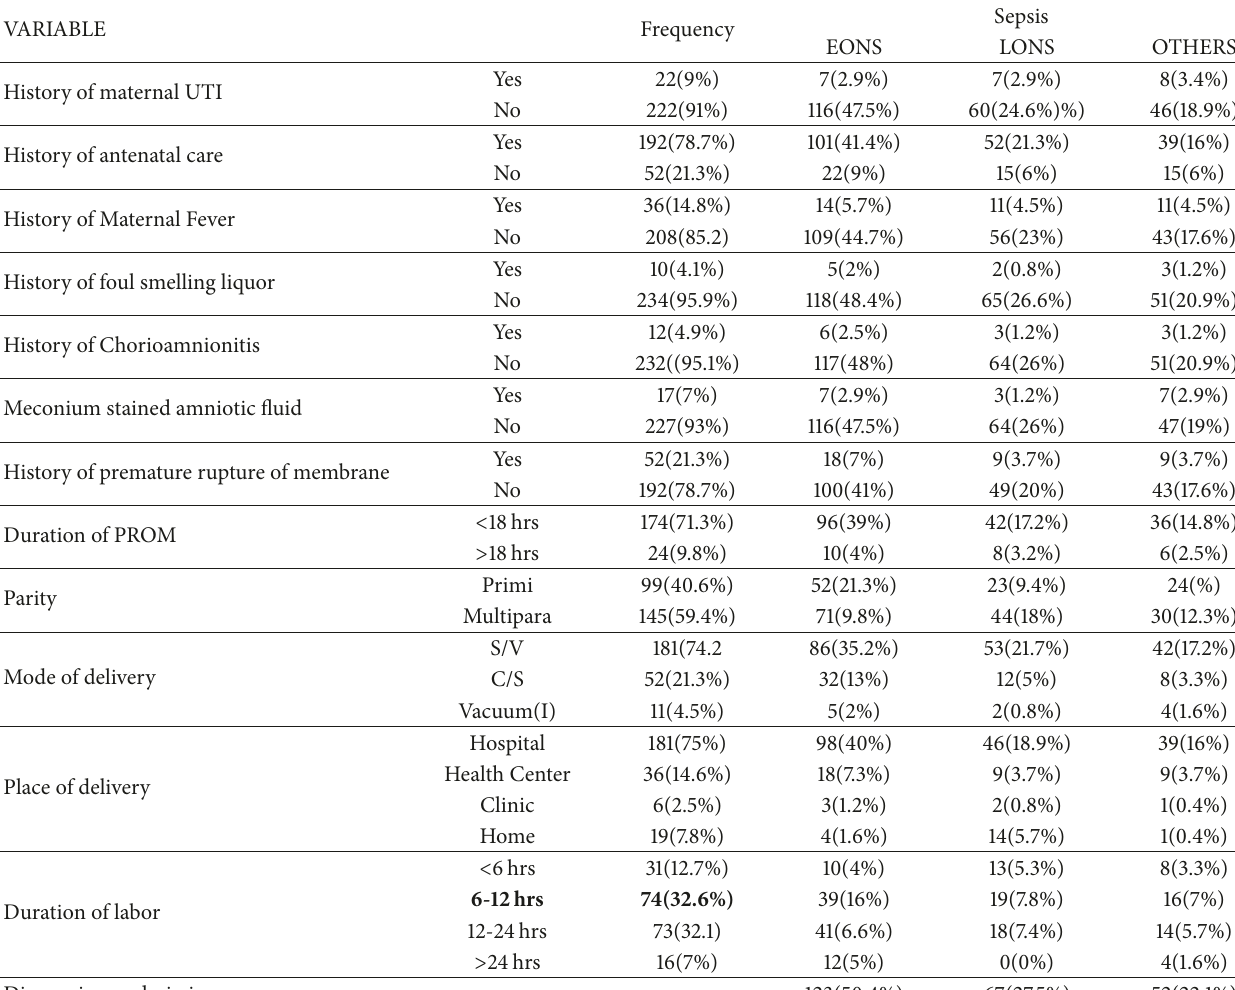
Table 2: Distribution maternal risk factors for neonatal sepsis among neonates admitted in Shashemenne referral hospital and Melka Oda district hospital in NICU wards, Ethiopia,